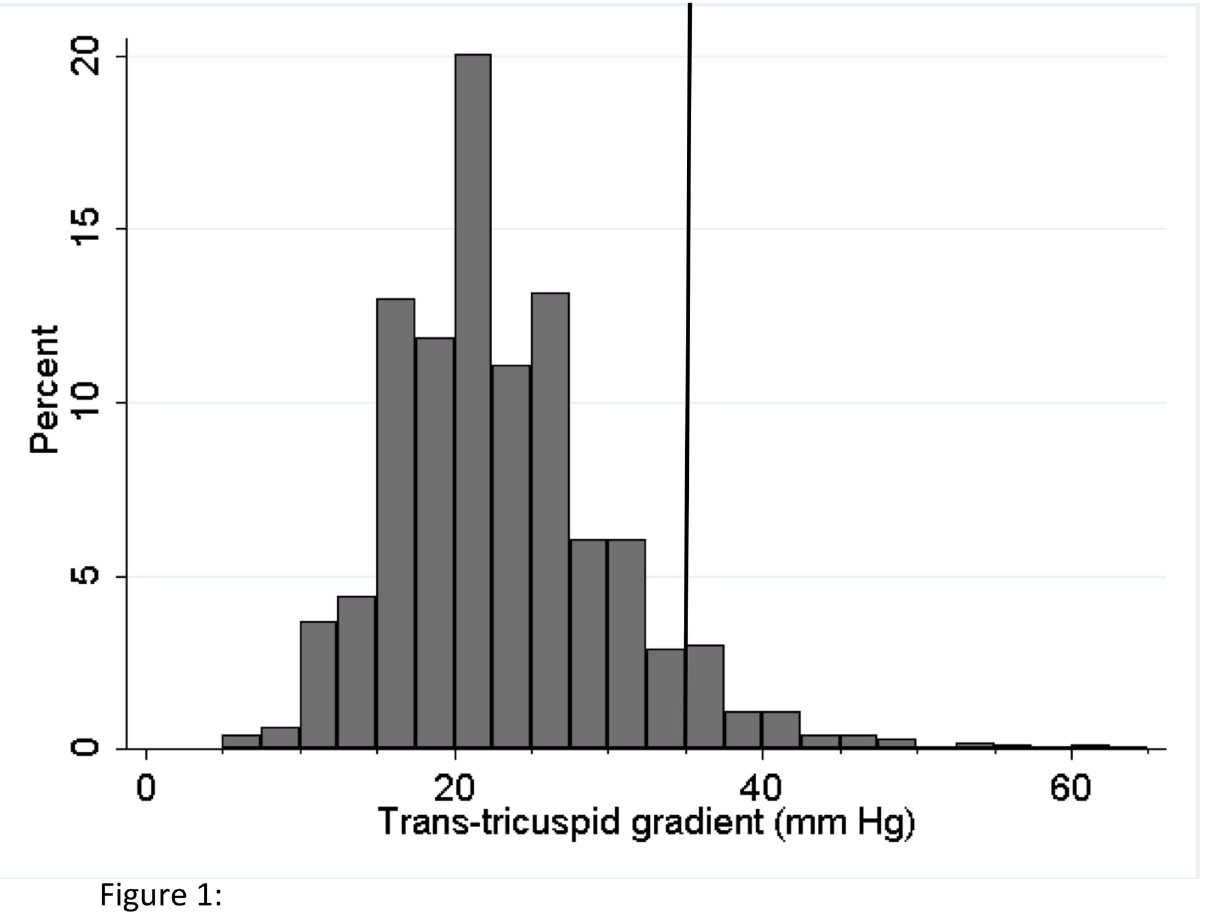
Figure 1. Distribution of trans-tricuspid gradients in study cohort. Vertical line indicates a gradient of 35 mm of Hg that was used as a cut-off for definition of pulmonary